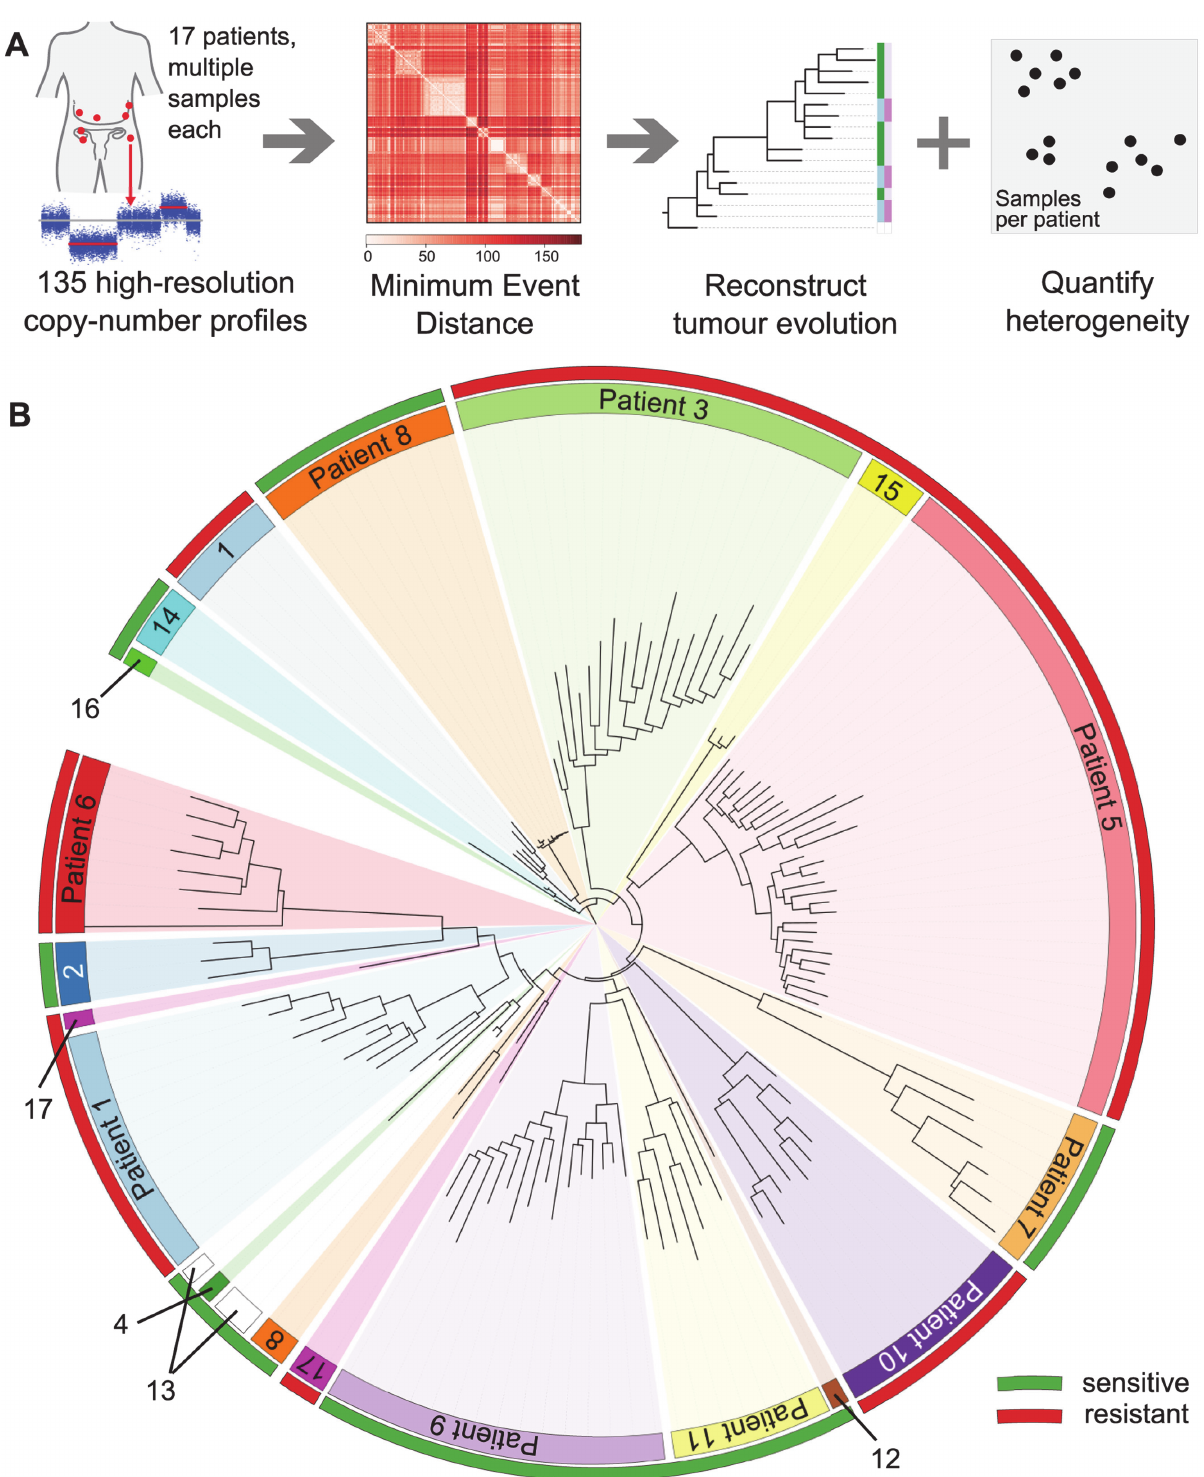
Fig 1. Overview of the analysis and the clinical dataset. (A) Numerical quantification of intra-tumour genetic heterogeneity by evolutionary comparisons. Copy number profiles from 135 metastatic sites were obtained for 17 patients with HGSOC. The MEDICC algorithm was used to compute minimum event distances between profiles and to reconstruct the evolutionary history for each sample, enabling numerical quantification of both spatial and TH and CE for each patient. (B) HGSOC exhibits significant patient-specific intra-tumour genetic heterogeneity. Neighbour-joining tree of all samples based on total copy